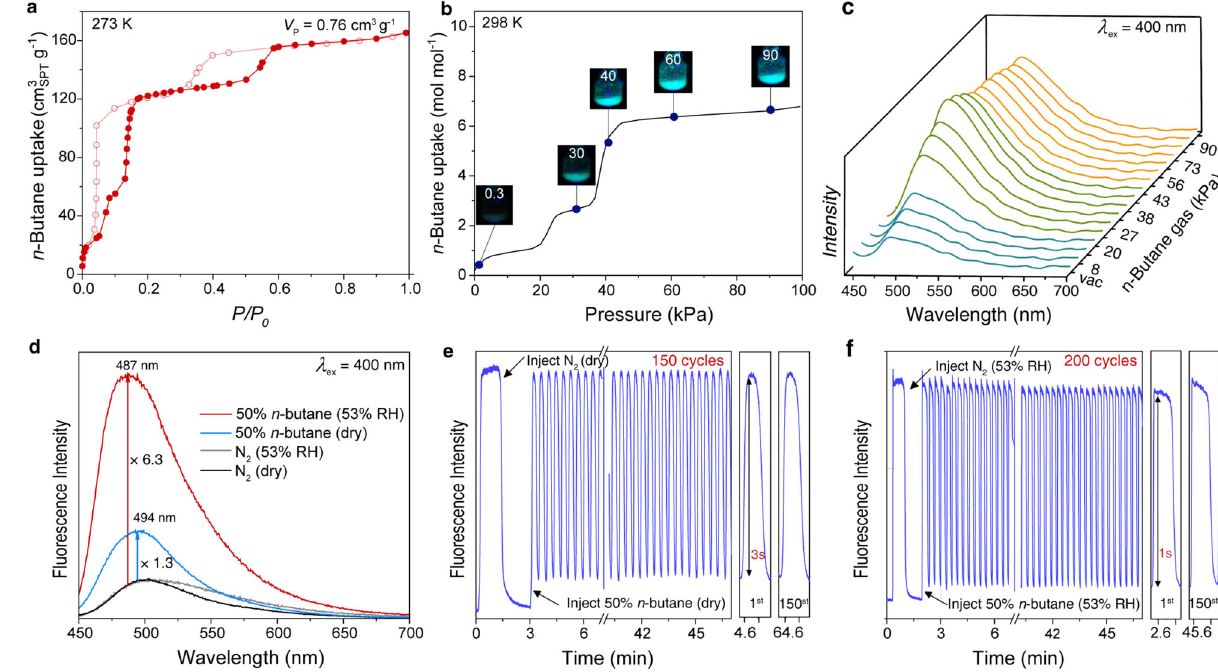
fl uorescence blueshift and boosted fl uorescence intensity of dynaCOF-330 upon injection of 50% n -butane under dry and humid condition (53%RH). The cyclic fl uorescence sensing of 50% n -butane under dry ( e ) and humid conditions ( f ,